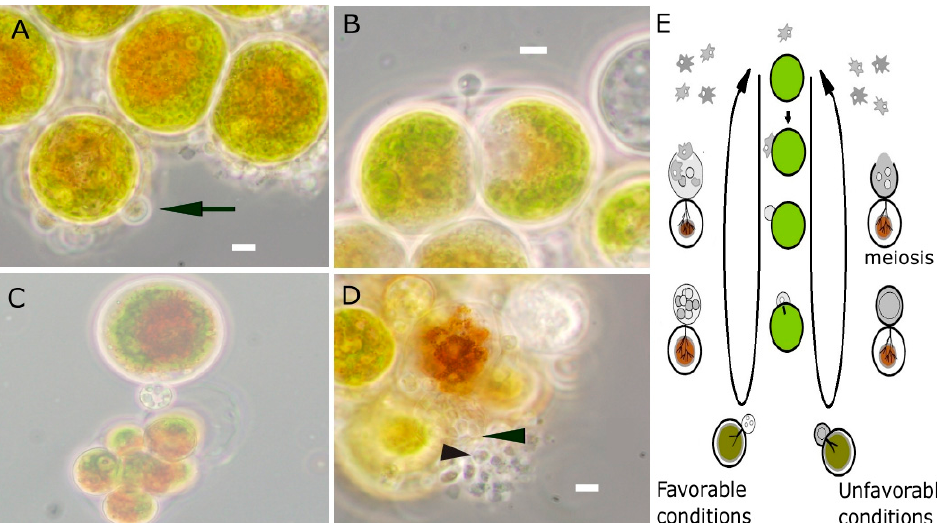
Figure 1. Phase contrast images of the first infection cycle of H. pluvialis by P. sedebokerense pure propagules and a schematic representation modified from Hoffman et al. 2008. ( A ) At 0.5 h after inoculation, the propagules are round as they start to encyst (arrow). ( B ) At 1 h after inoculation, the cysts produce a germ tube which penetrates the host cell wall. ( C ) At 9 h after inoculation, the cysts mature and lipid droplet clusters suggest that cyst turned into sporangium. ( D ) Moreover, 16 h after inoculation, the discharge pore (arrowhead) of the sporangia opened and the new next generation of amoeboid swarmers are released. Scale bars: 5 μ m. ( E ) Schematic representation of the life cycle of the infection of P. sedebokerense infecting H. pluvialis , showing the progression of the cycle under favorable and unfavorable conditions with formation of resting cysts with thicker cell wall and characteristic ventral vacuole that disappears prior to germinating.